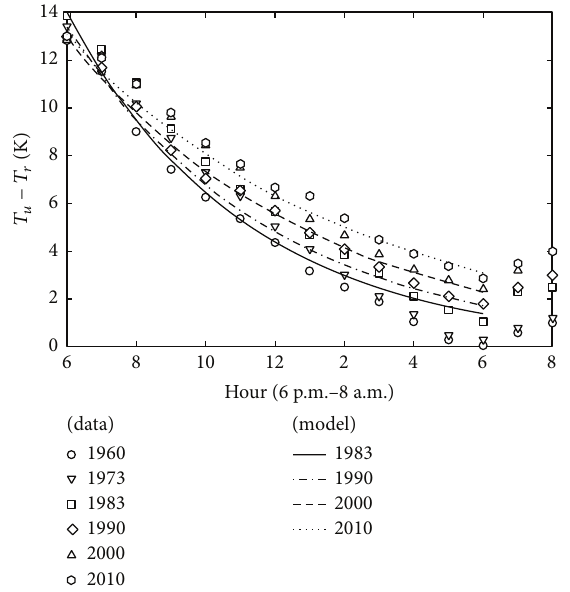
Figure 1: Temperature decay as a function of time, in Phoenix, AZ, for years 1960 to 2010, using